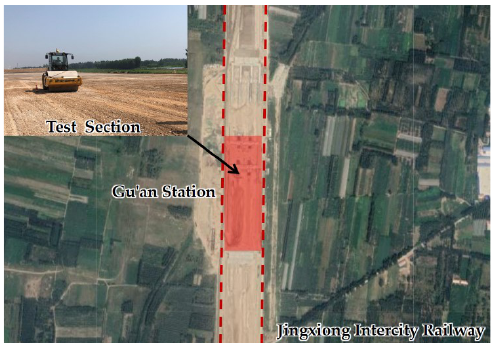
Figure 1. Test section.